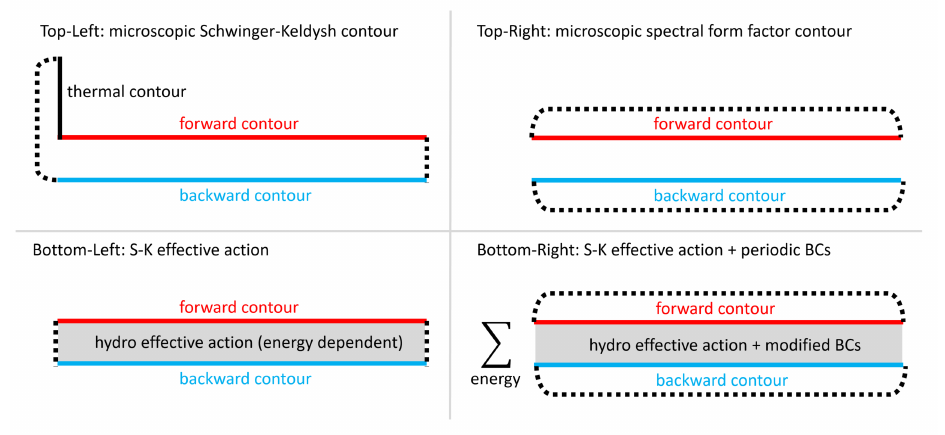
Figure 7 . The idea behind the Doubled Periodic Time (DPT) formalism. Just as how microscopic fields on a Schwinger-Keldysh contour are integrated out to give an effective field theory of hydro- dynamics, the microscopic degrees of freedom on an SFF contour are integrated out to give that same action, up to different boundary conditionals and exponentially small (in T )